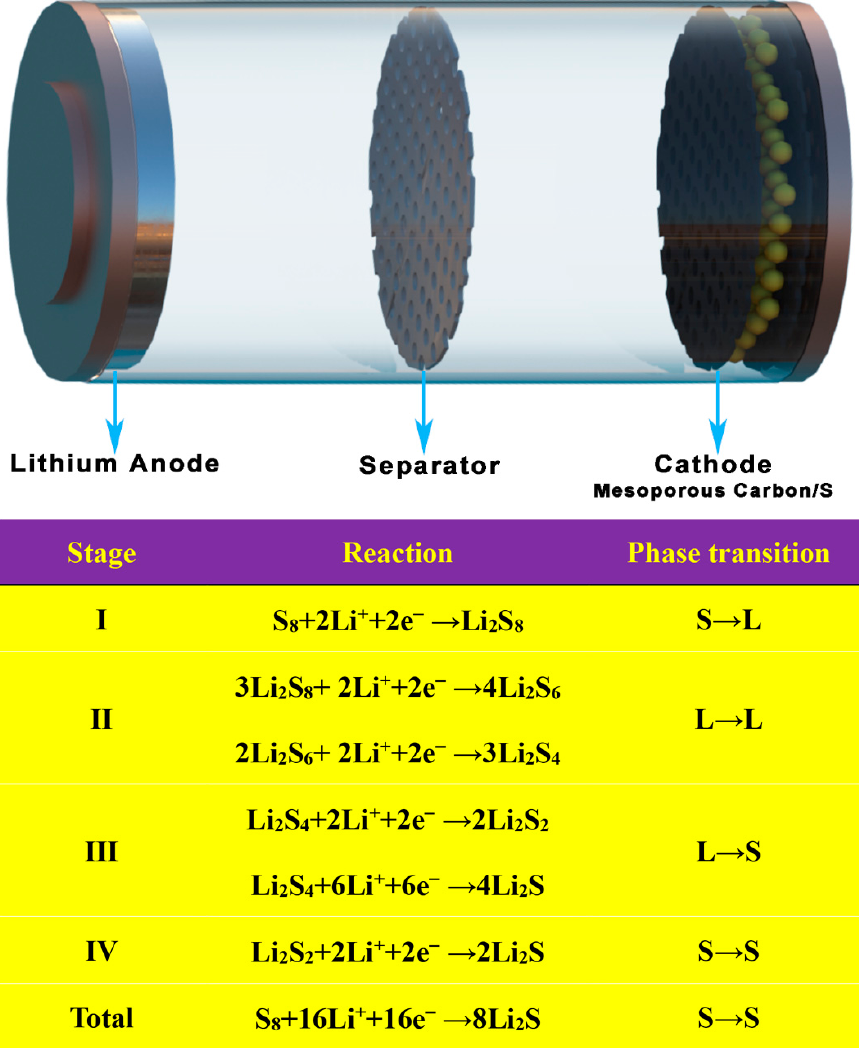
Figure 1. Structure and reaction mechanism diagram of LSBs.